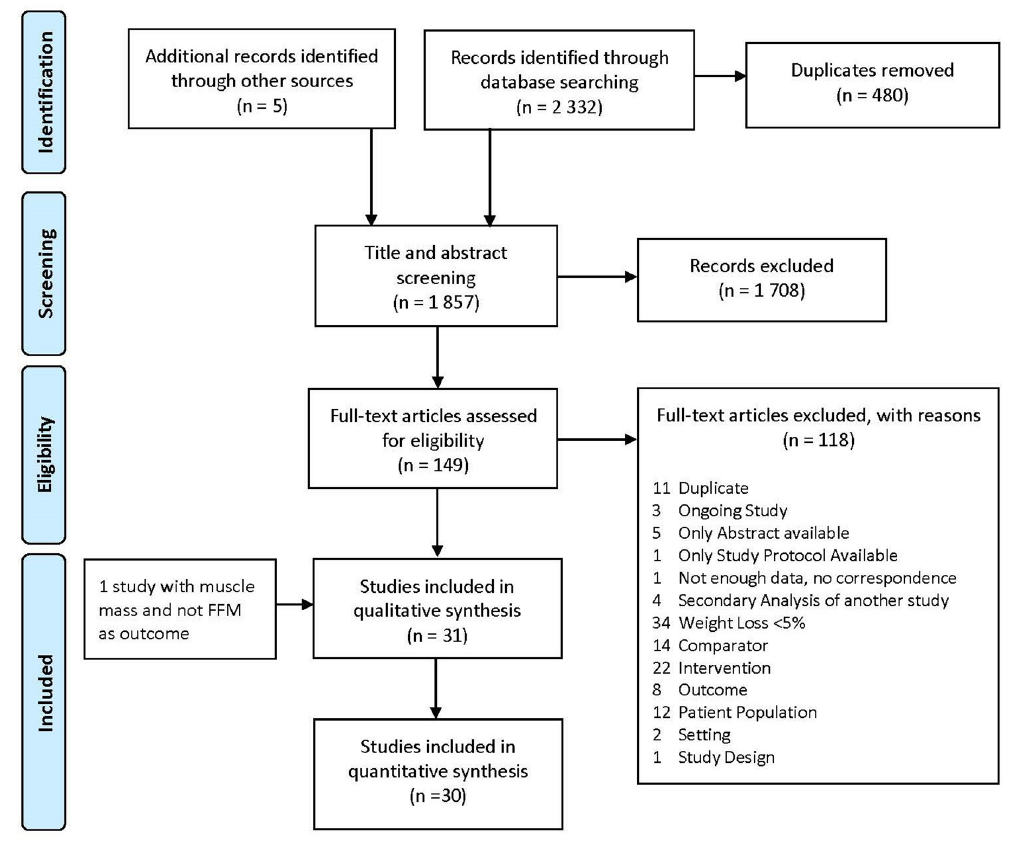
Figure 1. PRISMA flow chart describing the article selection